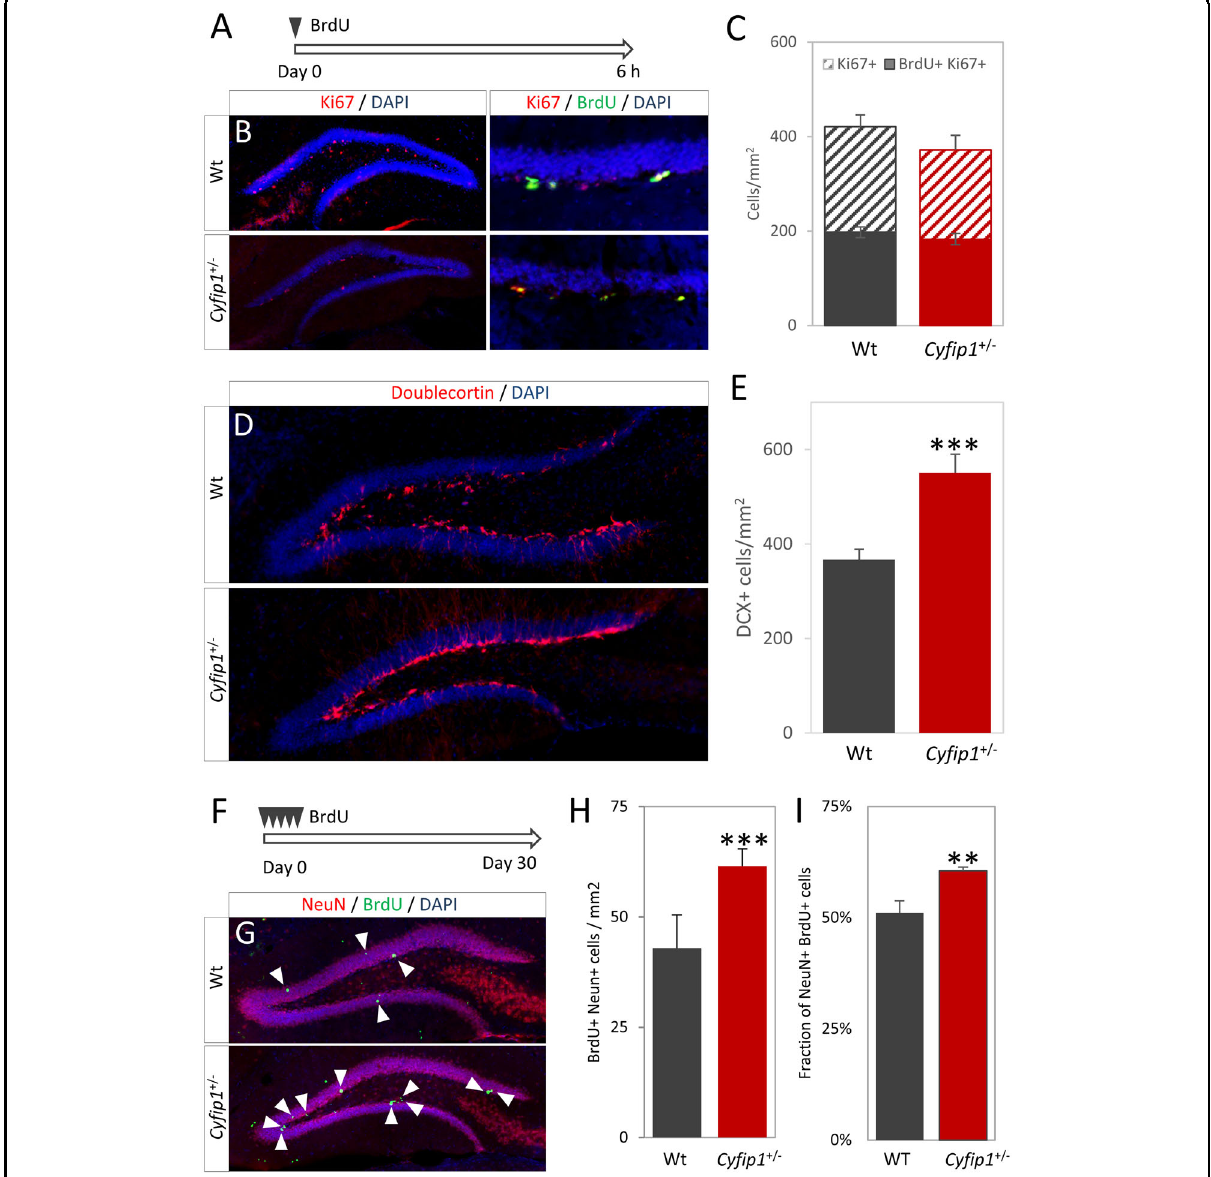
Fig. 1 Cy fi p1 haploinsuf fi ciency increases neurogenesis in vivo in the absence of changes in proliferation. A Experimental scheme , proliferation rates were studied with a 6 h pulse of BrdU. B Representative immunohistochemistry showing distribution and location of proliferative (Ki67 + ) and dividing (Ki67 + BrdU + ) cells in wild-type and Cy fi p1 + / − animals ( n = 4 each), respectively. C Quanti fi cation showed no difference in numbers of proliferative cells or number of cell divisions. D Representative staining for DCX in wild-type and Cy fi p1 + / − animals ( n = 8 each), respectively. E Quanti fi cation showed a signi fi cantly larger number of immature neurons in the Cy fi p1 + / − animals. F Experimental scheme , cell maturation was studied with a 30 day BrdU pulse-chase. G Representative images showing BrdU + and NeuN + cells. Arrowheads indicate BrdU + cells H Cyfp1 + / − animals ( n = 6) had signi fi cantly higher numbers of BrdU + NeuN + cells than the wild-type animals ( n = 5). l The fraction of BrdU + cells which had matured into NeuN + cells was signi fi cantly increased in the Cy fi p1 + / − animals. All data are shown as mean ±